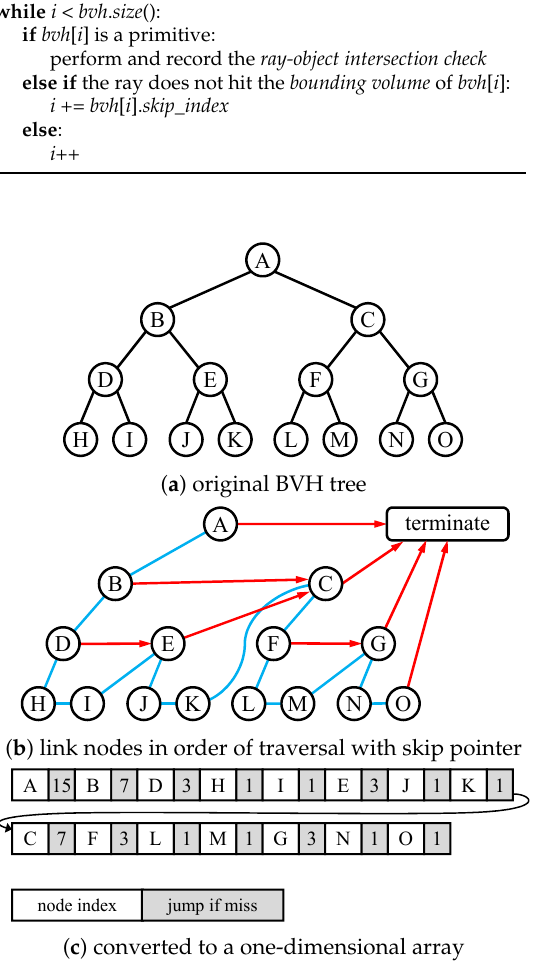
Figure 8. Constructing the roped BVH tree: blue lines denote the left-to-right traversal, while red arrows show the skip